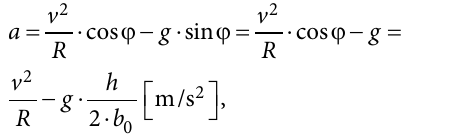
Input parameters Track